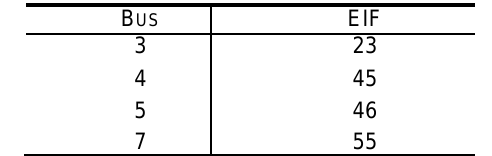
Table I. Incentive benefits for participates